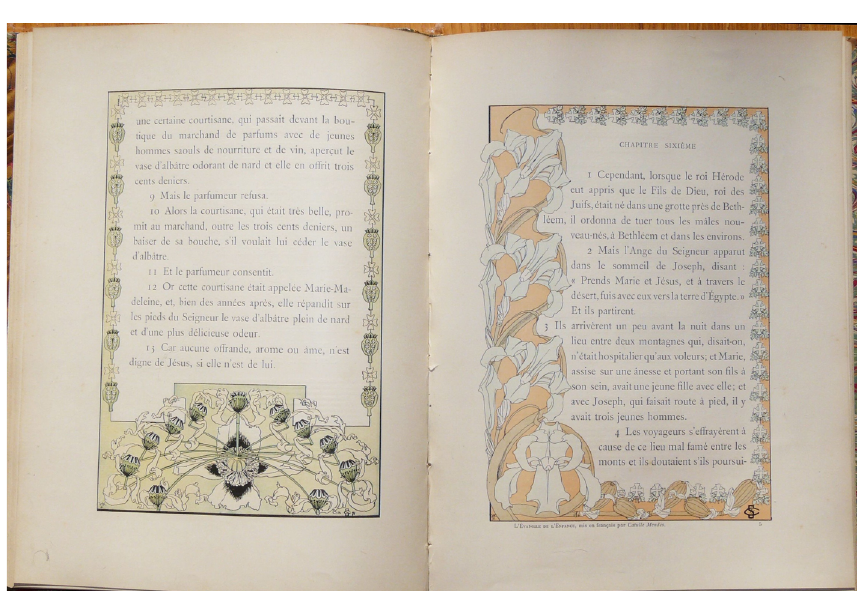
The same gathering in L’Évangile de l’enfance de Notre-Seigneur Jésus-Christ selon saint-Pierre, mis en français par Catulle Mendès d’après le manuscrit de l’abbaye de Saint-Wolfgang, compositions et encadrements de Carloz Schwabe (Paris: Armand Colin, [1896]). Private